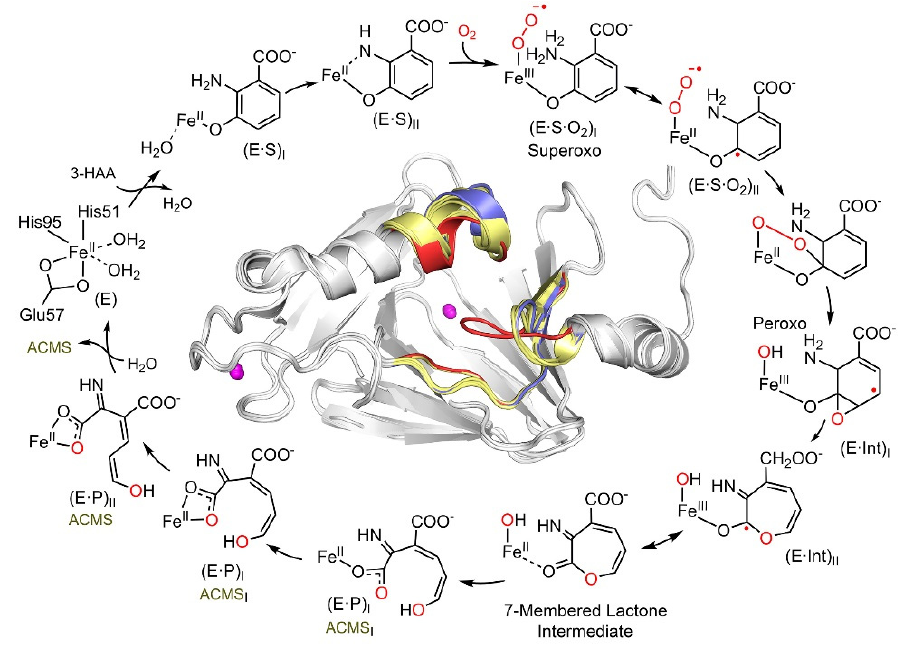
Figure 2. The HAO catalytic reaction cycle is characterized by in crystallo chemical reaction. The structurally characterized intermediates include monodentate E•S complex, bidentate E•S com- plex, Fe-bound superoxo, alkylperoxo, ɛ –lactone, monodentate, and the reaction product bidentate 3 E ,5 Z ,2 t ,4 c –enol tautomer of ACMS, as well as bidentate 3 E ,5 Z ,2 t ,4 t –enol tautomer of ACMS. The (E•Int) radical intermediates are implicated by the single-crystal EPR spectroscopy, although not structurally resolved. The inset shows the overall structure and dynamic loop change near the cat- alytic site which occurs during catalysis. The loops of substrate-free, bidentate E•S complex, and subsequent intermediates are colored in blue, red, and yellow, respectively. For more details regard- ing the catalytic pathway intermediate structures and loop dynamics, see References